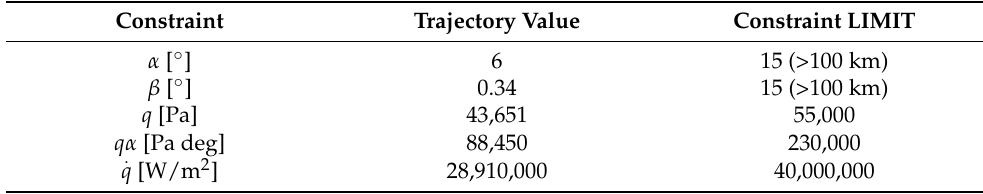
Table 11. Maximum values of the constraints in the